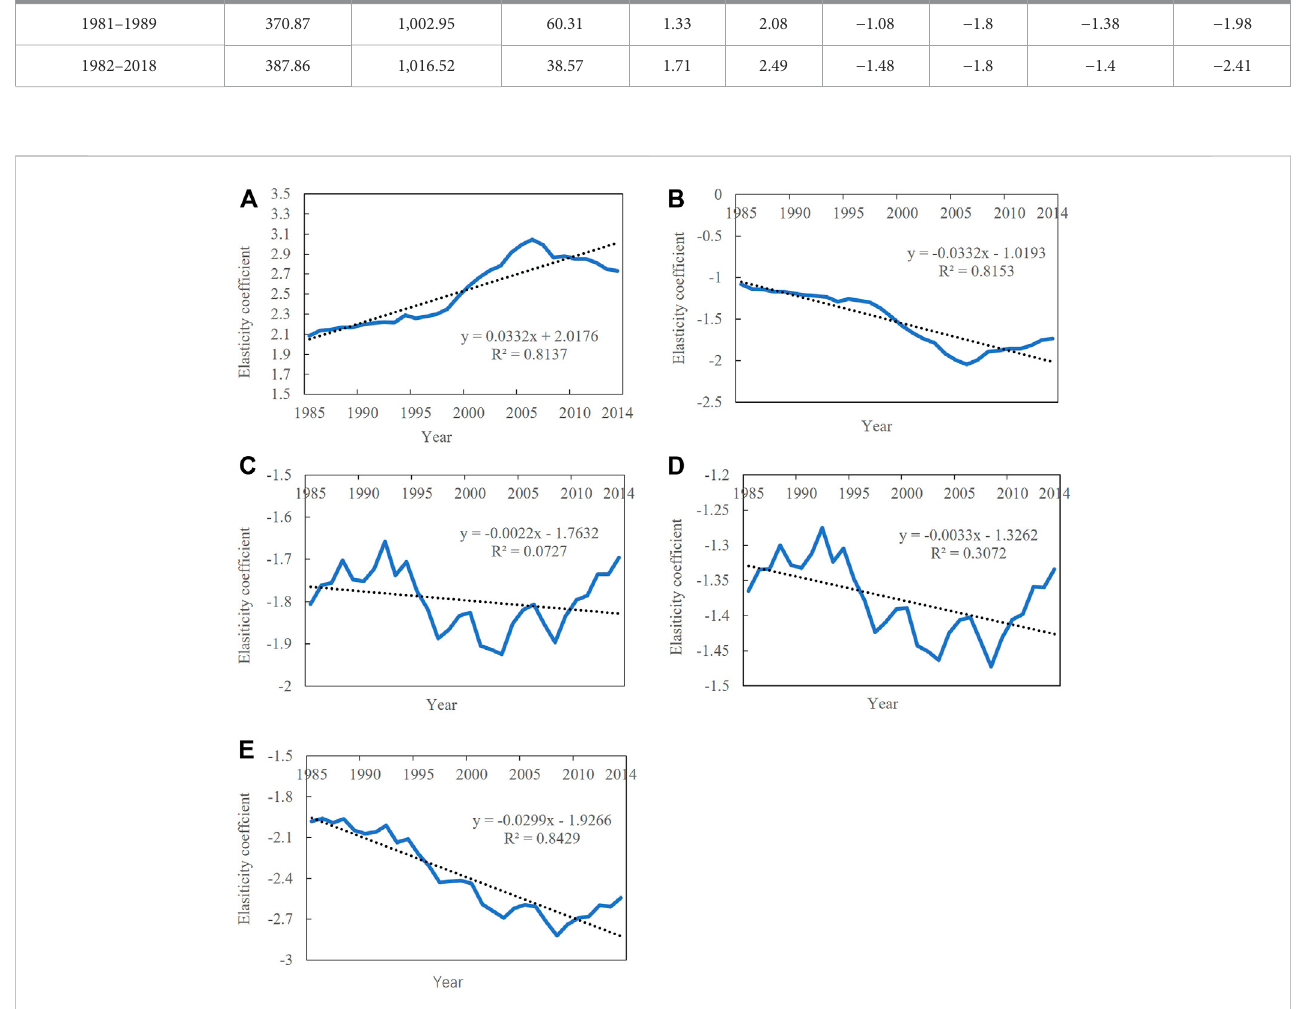
FIGURE 3 Correlation between climate and human activity factors and underlying surface parameters. (A) p, (B) ET 0 , (C) n c , (D) n h1 , (E) n h2 .